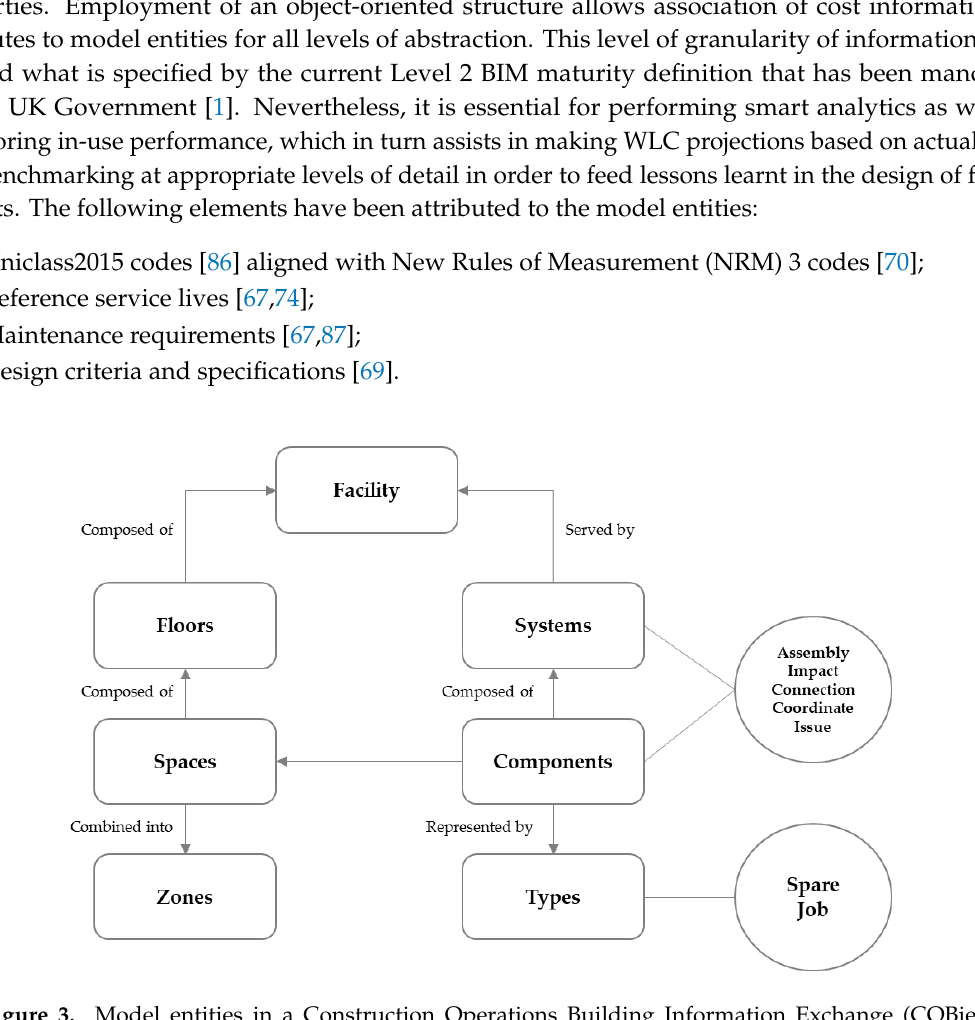
Table 2. Sub-elemental breakdown for extraction of quantities.